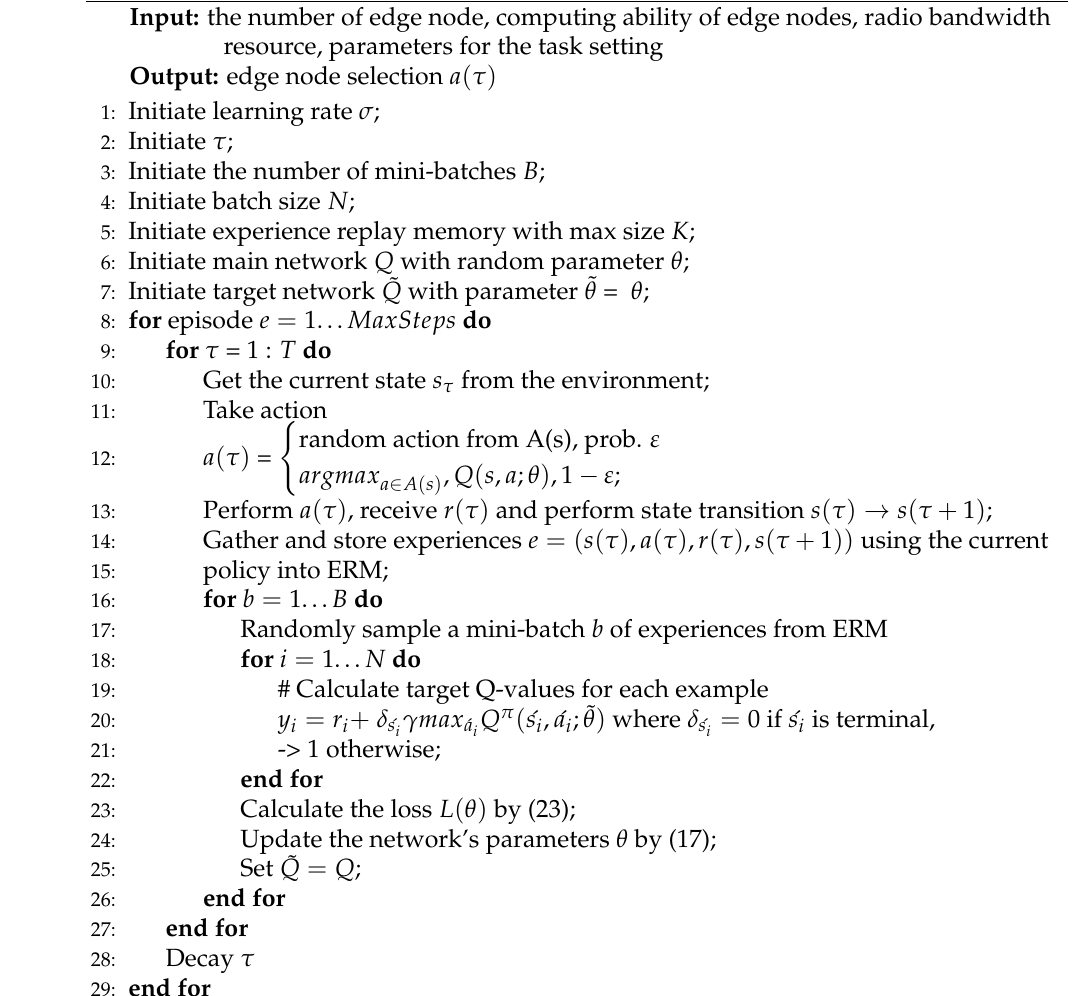
Algorithm 1 Intelligent task dispatching algorithm in the cluster